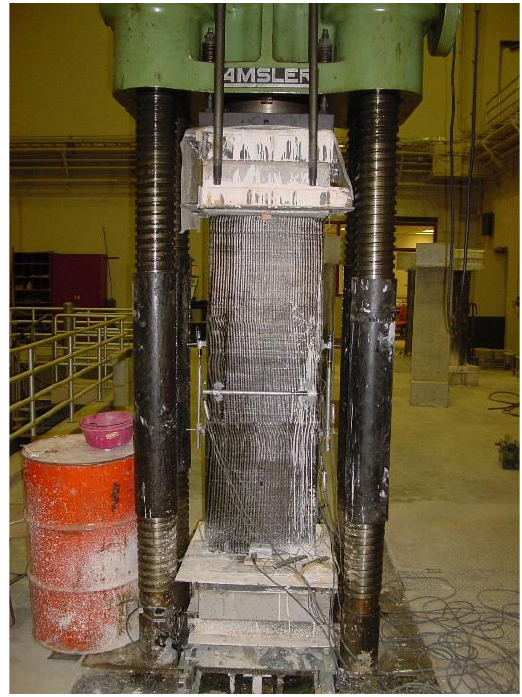
Figure 4. Test setup.